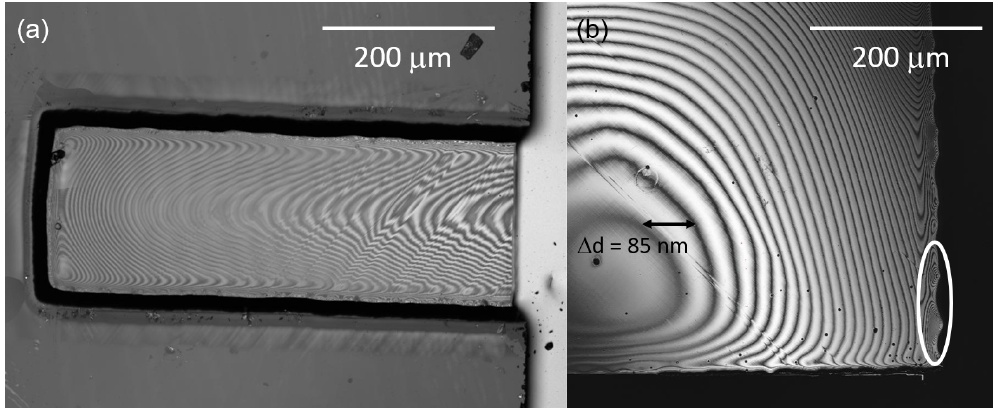
Figure 3. Interference fringes of the etched membranes recorded using a confocal laser scanning microscope (LSM): ( a ) Thickness homogeneity of a membrane etched with the SF 6 -based recipe. The thickness of the membrane at the outer edge (thinnest point) is 2.5 µ m as measured using SEM. The diamond membrane shows a thickness variation of 3.6 µ m along its long edge and a variation of 0.8 µ m along its short edge direction. Measured using a LEXT OLS4100 LSM (Olympus, Shinjuku, Japan) equipped with a 405nm laser; ( b ) Membrane etched using the Cl 2 -based process, compare Figure 2b. The thickness of this membrane at its outer edge is 2 µ m as measured using SEM. The encircled area illustrates the local variation of the trenching as described in the text. Measured using a VK-X210 LSM (Keyence, Osaka, Japan) equipped with a 408nm